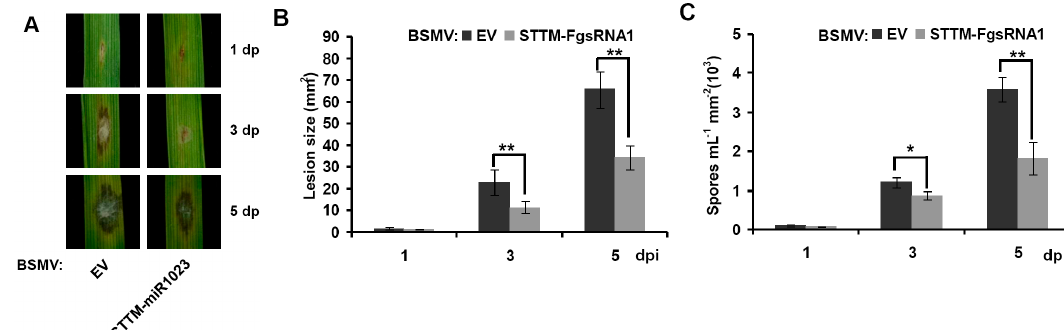
Figure 5. Analysis of lesion size of wheat leaves and F. graminearum spores number after BSMV induced Fg-sRNA1 silencing. ( A ) Lesion area phenotypes of F. graminearum infected wheat leaves which were pre-inoculated by BSMV empty vector (BSMV: EV) and BSMV: STTM-FgsRNA1, were photographed at 1, 3 and 5 dpi. BSMV = EV infected wheat plants were used as controls; ( B ) lesion-size (mm 2 ) of corresponding different treatments; and ( C ) number of F. graminearum spores produced by lesions on corresponding treated wheat leaves. Error bars representing SE were calculated from three replicates. Significance was determined at * p < 0.05 and ** p < 0.01 ( n ≥ 3) with a t -test.